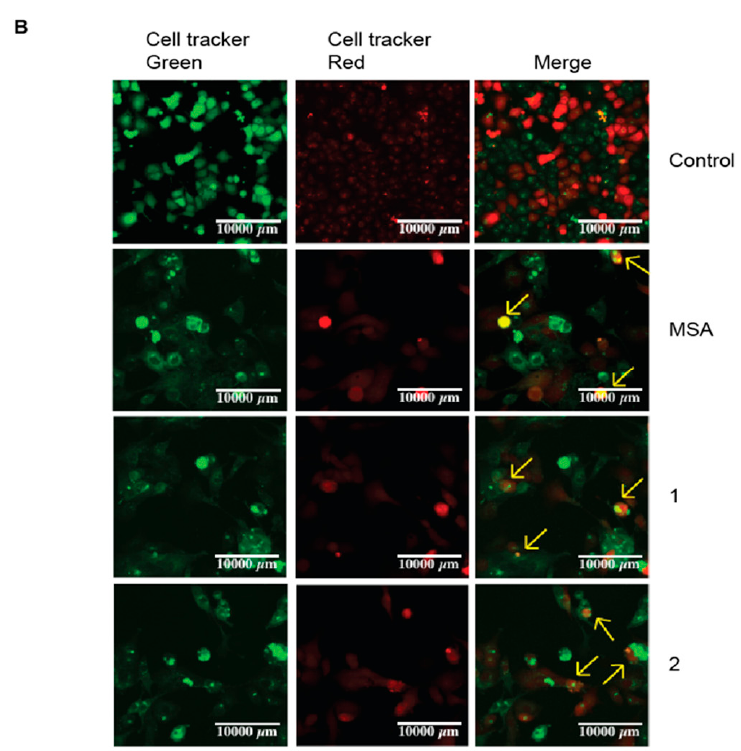
Figure 4. MSA, and compounds 1 and compound 2 induce entosis in Panc-1 cells. ( A ) Western blot analyses of Cathepsin B, Cathepsin D, CDC42, and Rho A upon treatment with MSA or compound 1 or compound 2 for 24 h. Beta actin was used as a loading control. The corresponding graphs display a quantitative analysis of western blots performed using the ImageJ program and GraphPad Prism software. Error bars indicate mean ± SEM of three biological replicates. ( B ) Panc-1 cells stained with CellTracker Red or Green and further mixed (1:1) were treated with MSA or compound 1 or compound 2 for 18 h, followed by live imaging using a confocal microscope, Zeiss LSM800. The arrows indicate cell-in-cell formations i.e., cells undergoing entosis. Statistical significance as compared to control * p < 0.05, ** p < 0.01, *** p < 0.001.